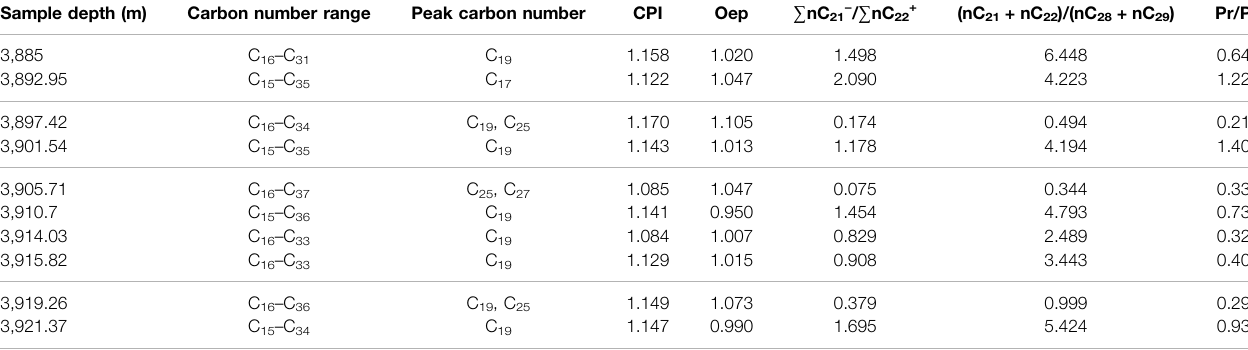
TABLE 1 | Statistics of the saturated hydrocarbon chromatographic parameters of shale samples from well Y1. Sample depth